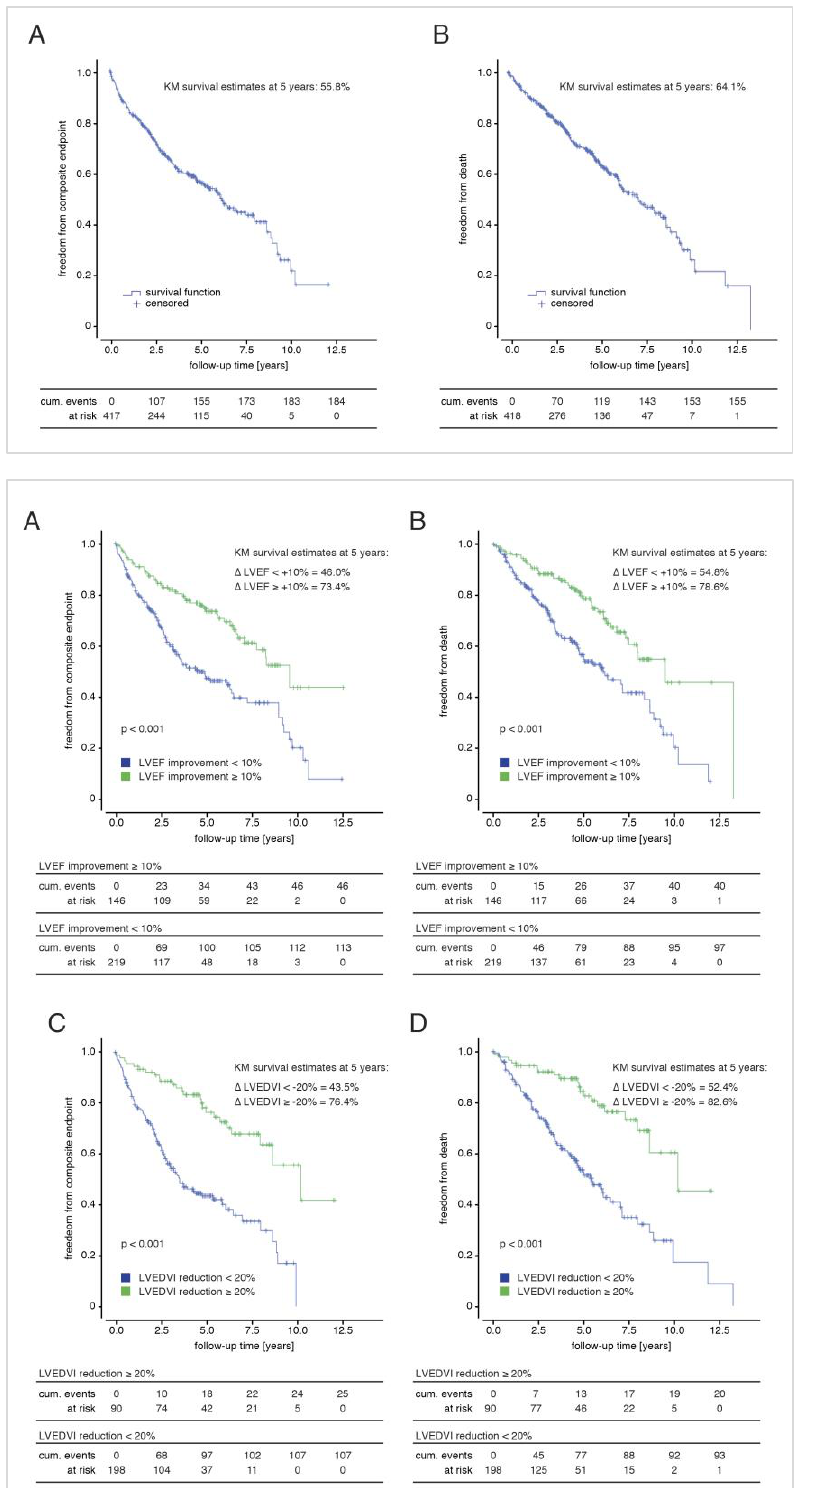
Figure 3: Follow-up for survival and rehospitali- sation for congestive heart failure. Kaplan-Meier survival estimates for (A) the composite end- point of hospitalisation for heart failure or all- cause mortality (defined as death, heart trans- plantation or ventricular assist device implanta- tion) and (B) the endpoint of mortality alone. Follow-up began at the time point of cardiac re- synchronisation therapy implantation. Median follow-up time was 3.6 years (interquartile range 1.9–5.7).